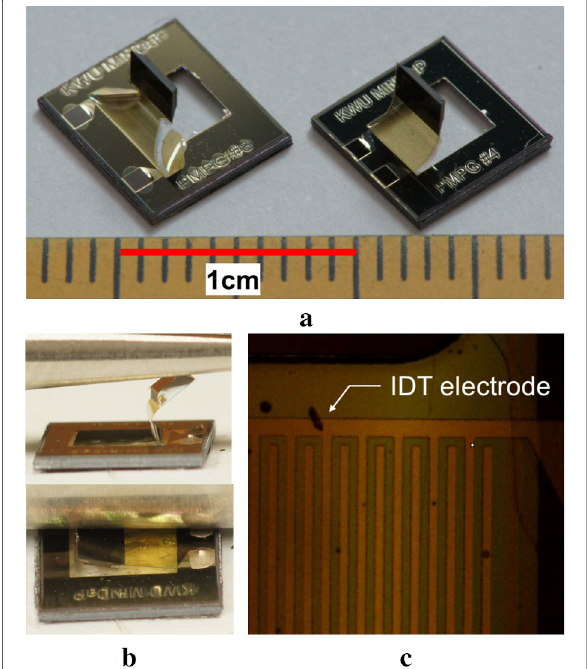
Fig. 4 Photograph of the micro-fabricated flexible PZT cantilever based energy harvester: a trapezoid ( left ) and rectangular ( right ) shaped cantilevers, b visual inspection of flexibility in the fabricated polyamide/PZT cantilever, and c inter-digitated electrodes for piezo- electric d 33 -mode operation on the rectangular shaped cantilever